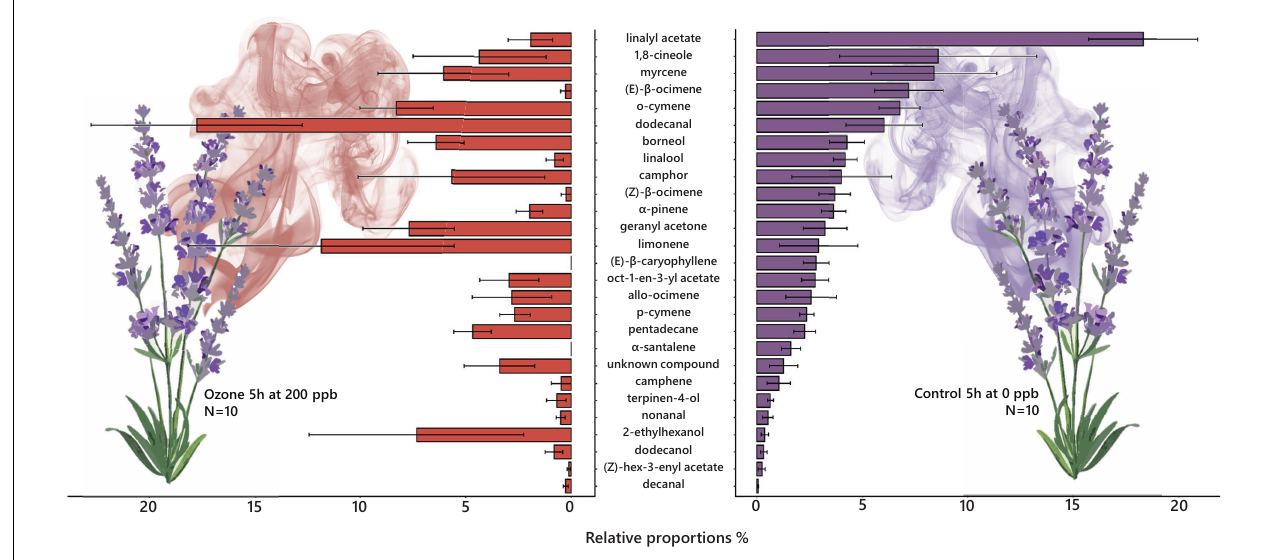
FIGURE 4 | Relative proportions of volatile organic compounds (VOCs) emitted by flowering lavenders in experiment 1 exposed to 0 ppb O 3 for 5 h (right) vs. proportions of VOCs emitted by flowering lavenders exposed to 200 ppb O 3 for 5 h (left). Mean ± standard error per individual of the relative proportions of VOCs emitted by 10 plants without O 3 in the chamber and by 10 plants exposed to 200 ppb O 3 for 5 h.